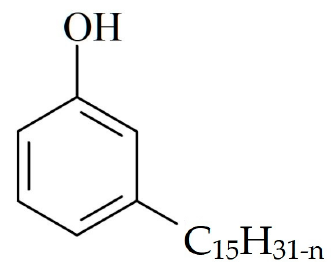
Figure 1. Chemical structure of cardanol; n depends on the number of unsaturations [12].